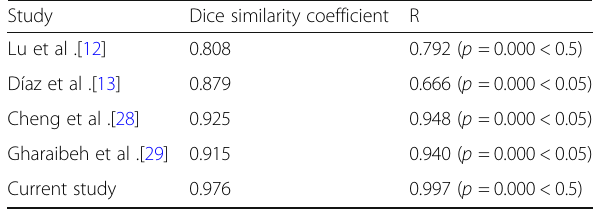
Table 3 Comparison of the segmentation performance between our proposed method and similar